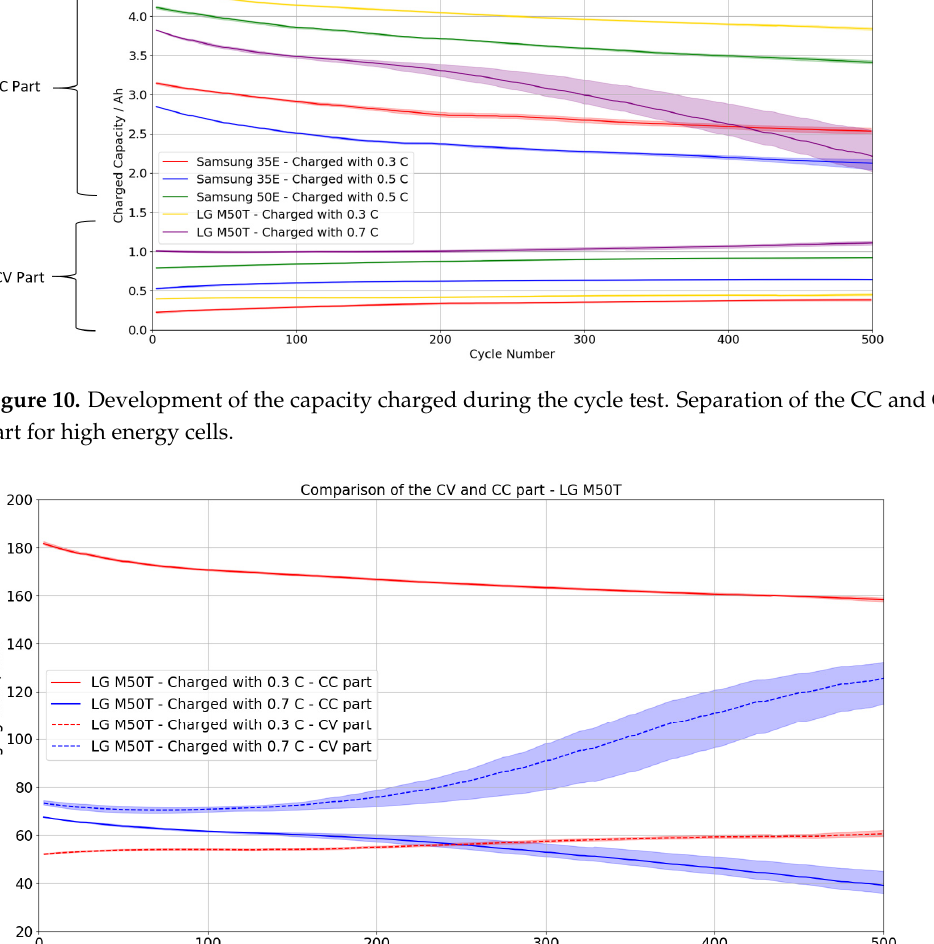
Figure 10. Development of the capacity charged during the cycle test. Separation of the CC and CV part for high energy cells.